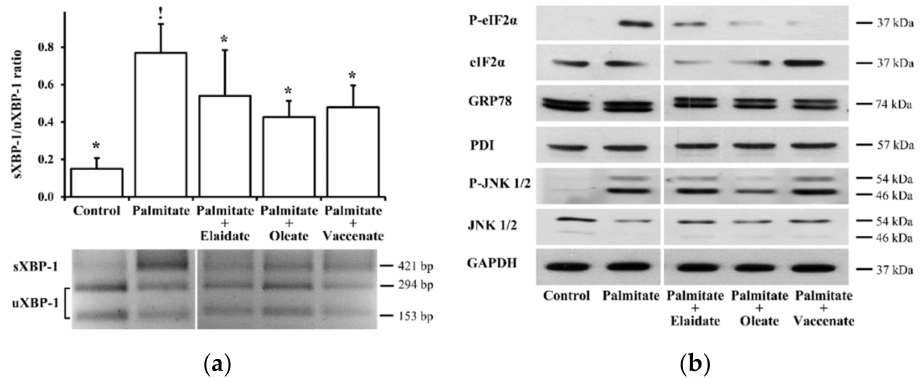
Figure 3. Stress markers. Cells were treated with BSA (control cells) or BSA-conjugated palmitate alone, or with palmitate in combination with one of the unsaturated fatty acids, elaidate, oleate or vaccenate at 500 µ M individual concentrations for 8 h at 70%–80% confluence. ( a ) Total RNA was prepared and a 447 or 421 bp long sequence was amplified by RT-PCR from “spliced” sXBP-1 or “unspliced” uXBP-1 mRNA versions, respectively. A better visualization was aimed for by PstI restriction endonuclease digestion, which leaves sXBP-1 cDNA uncut (421), while cleaves uXBP-1 cDNA to two fragments (153 and 294 bp). The cDNAs were separated by 2% agarose gel electrophoresis, the band densities were quantified by densitometry, and sXBP-1 / uXBP-1 density ratios were calculated. A typical gel image obtained in one of three independent experiments is presented. ( b ) Phosphorylated eIF2 α (P-eIF2 α ), 78 kDa glucose-regulated protein (GRP78 / BiP), protein disulfide isomerase (PDI), phosphorylated SAPK / JNK isoforms (P-JNK 1 / 2) protein levels were detected by Western blot in the cell lysates. The images show typical results of three independent experiments with two parallels. The results were quantified by densitometry, normalized to GAPDH levels and are presented as relative band densities in the percentage of palmitate-treated samples. Data are shown as mean values ± S.D.; n = 6; ! p < 0.05, vs. BSA-treated control; * p < 0.05, vs. palmitate-treated